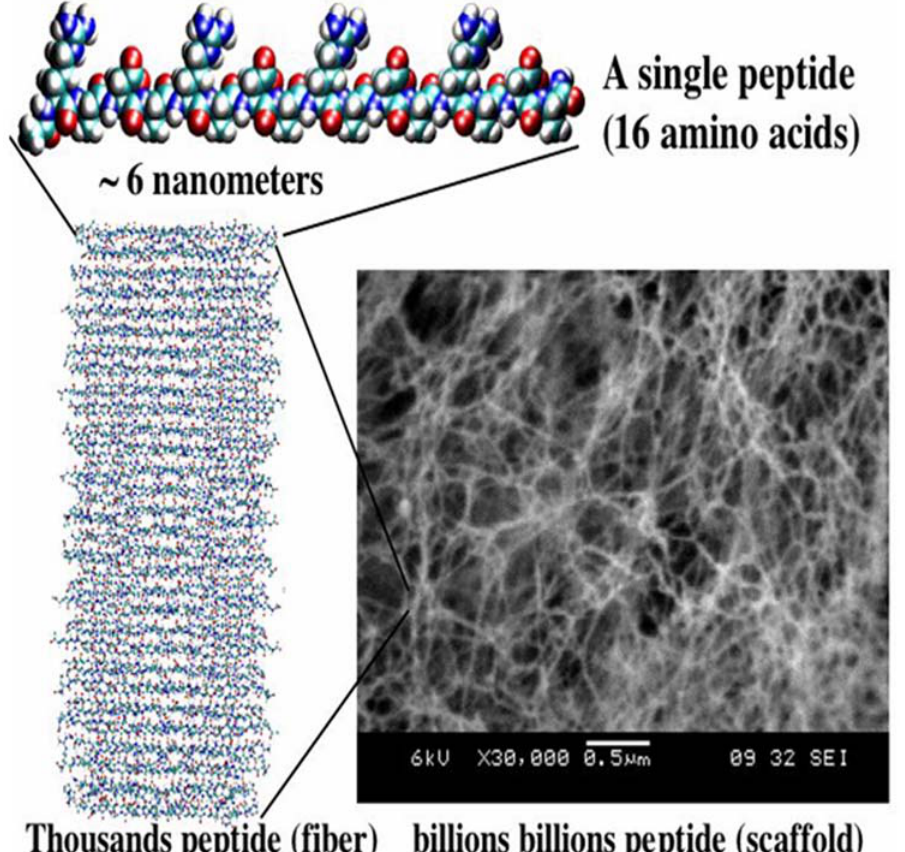
Figure 1. A designer self-assembling peptide nanofiber scaffold. A single peptide, approximately 6 nanometers, is shown. Thousands of peptides self-assemble to form a single nanofiber, trillions of peptides or billions of nanofibers form the scaffold that contains < 99.5% water and 0.5% peptide materials [16]. Positive and negative charges are labeled in blue and in red, respectively.